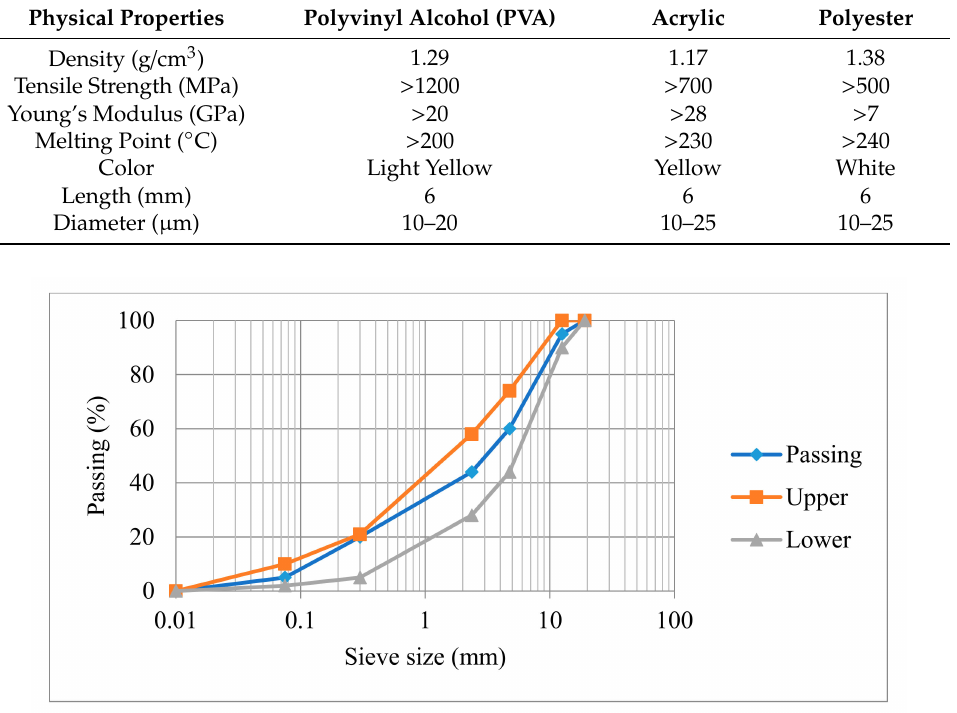
Figure 2. The finer gradation of the nominal maximum size aggregate of 12